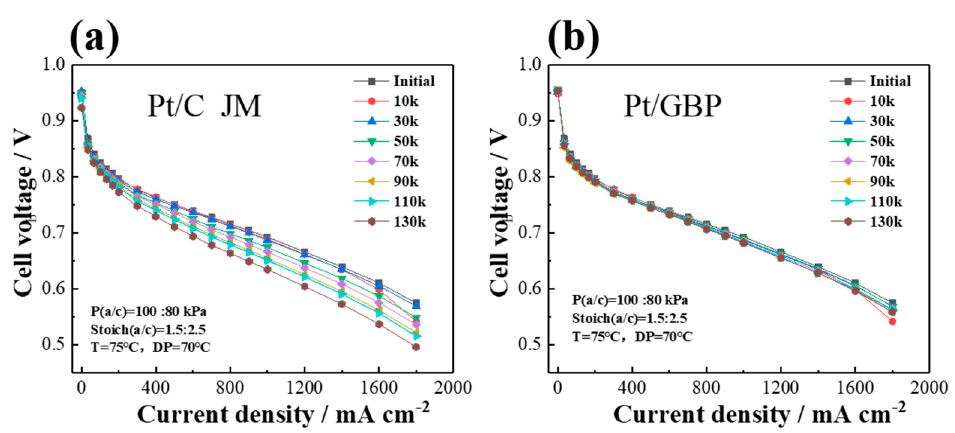
Figure 5. Polarization curves of MEAs with ( a ) commercial Pt/C and ( b ) Pt/GBP catalyst during 130 k cycles ADT between 0.6-1.0 V.